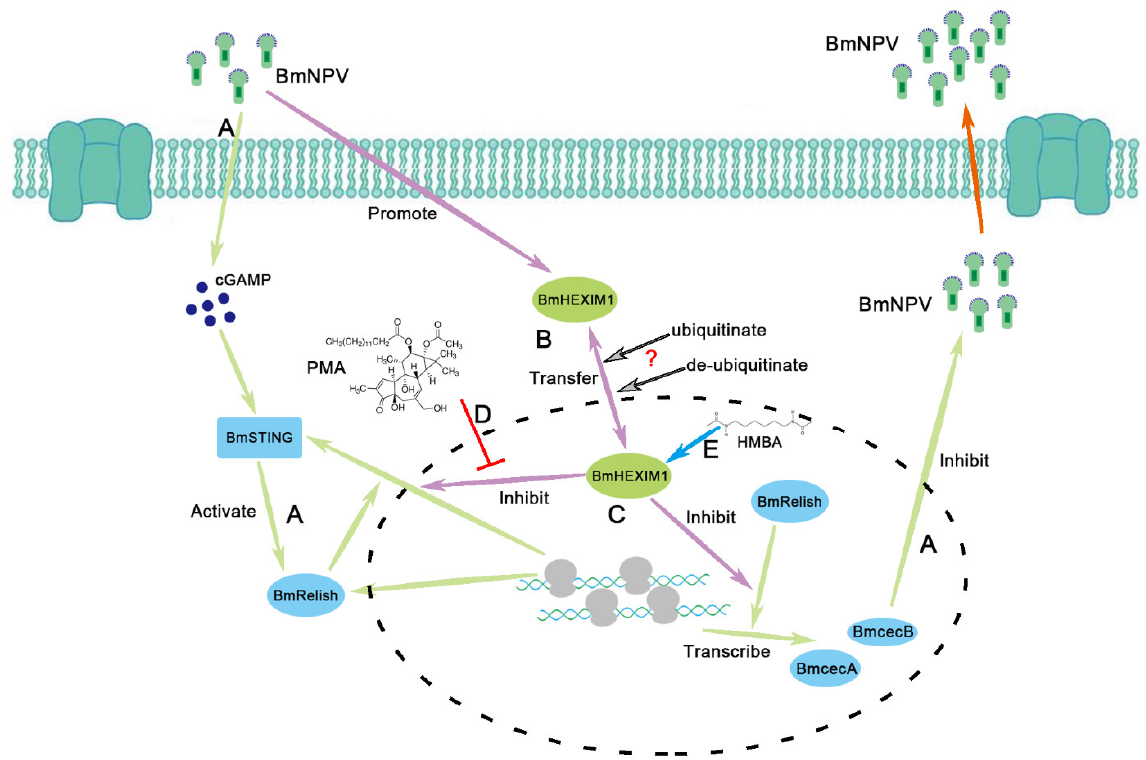
Figure 6. Schematic representation of the putative mechanism(s) of BmHEXIM1 in assisting BmNPV evade antiviral immune response and promoting BmNPV proliferation. (A) BmNPV significantly induced BmHEXIM1 expression, while activating host antiviral pathways, such as STING and Relish. The innate immune pathway mediated by BmRelish can induce the expression of BmSTING antimicrobial peptide genes (BmcecA and BmcecB) to resist BmNPV infection. (B) Altered subcellular localization of BmHEXIM1 may be regulated by ubiquitination following viral infection. “? “ were provided as “not determined”. (C) BmHEXIM1 inhibits BmRelish-dependent transcription, leading to suppression of the host’s antiviral response. (D) Stimulation of PMA inhibits BmHEXIM1 to repress BmRelish-dependent transcription. (E) HMBA treatment induces BmHEXIM1 expression to suppress host antiviral response.